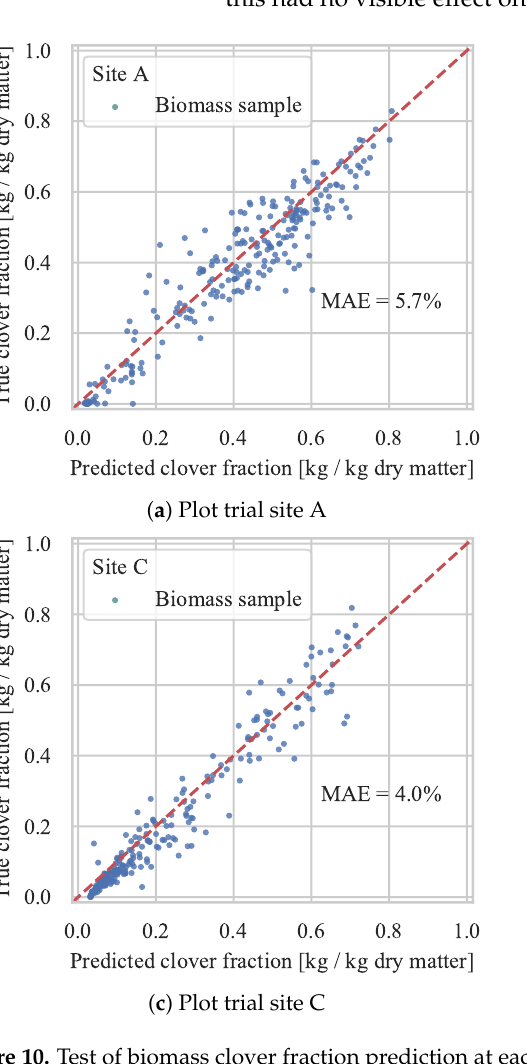
Figure 10. Test of biomass clover fraction prediction at each plot trial site, based on a first order linear model fitted to the remaining three sites. The site-specific mean absolute error, denoted MAE, is printed in each